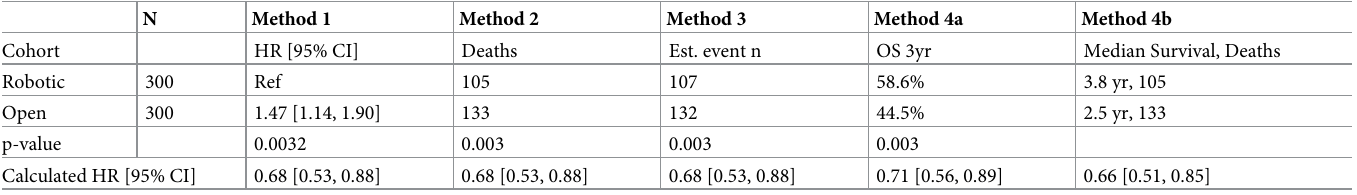
Table 2. Comparison of hazard ratios Method 1 through 4. Comparison showing information required for calculation of hazard ratio using various methods and result- ing hazard ratio and 95% confidence interval.